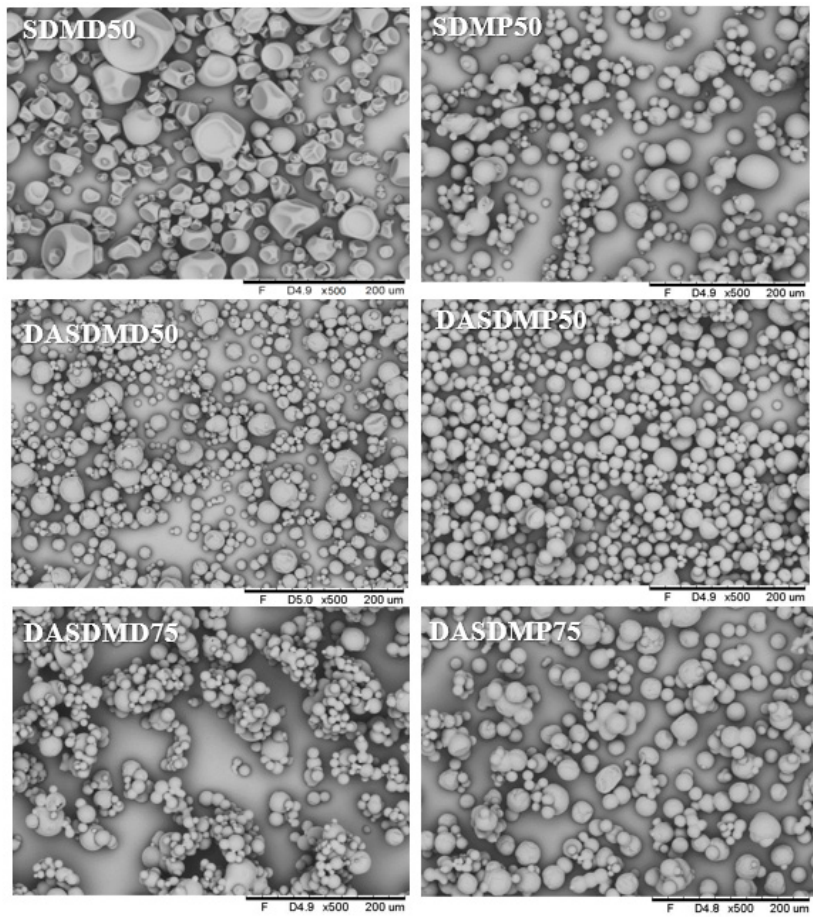
Figure 2. Scanning electron microphotographs (SEMs) of buckwheat honey powders containing 50 and 75% honey solids obtained with maltodextrin (MD) or milk powder (MP) as carriers by conventional spray drying (SD) and dehumidified-air-assisted spray drying